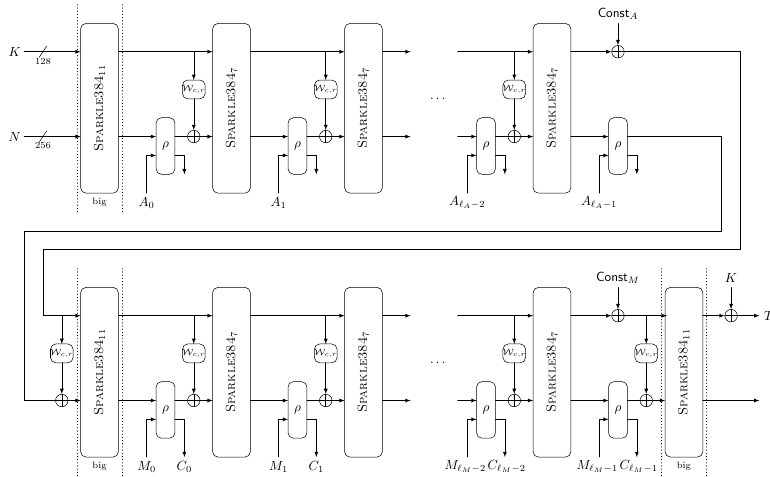
Figure 4: The AEAD Algorithm Schwaemm 256-128 with 𝑟 = 256 and 𝑐 =